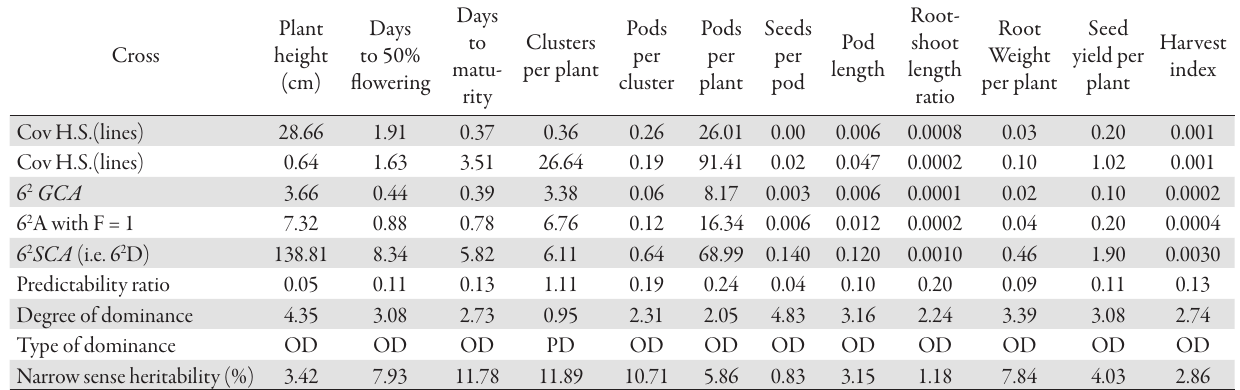
OD and PD denote overdominance and partial dominance, respectively